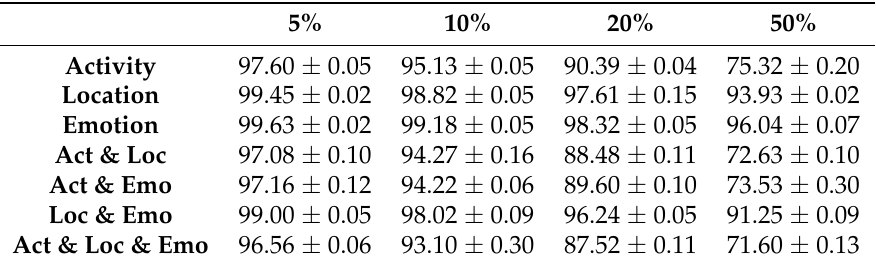
Table 1. Mean and standard deviation of the accuracy of the high-level context recognition under different levels of errors in the detected low-level